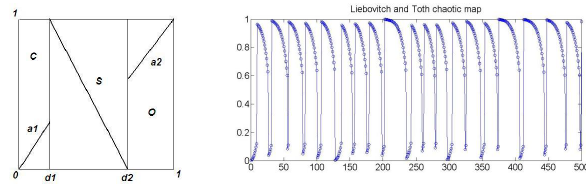
Figure 4. Liebovitch and Thot map and an excerpt of the generated time series. Fig. 4. Liebovitch and Thot map and an excerpt of the generated time